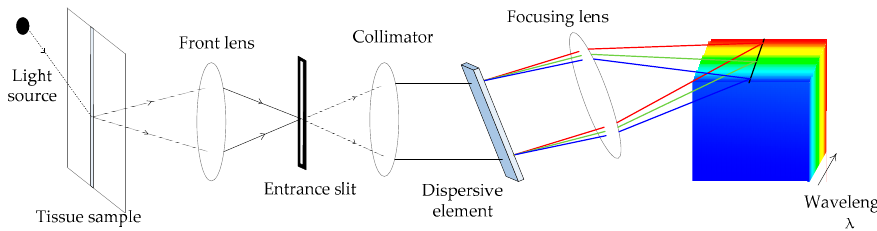
Figure 2. Schematic diagram of push-scan hyperspectral imaging system.